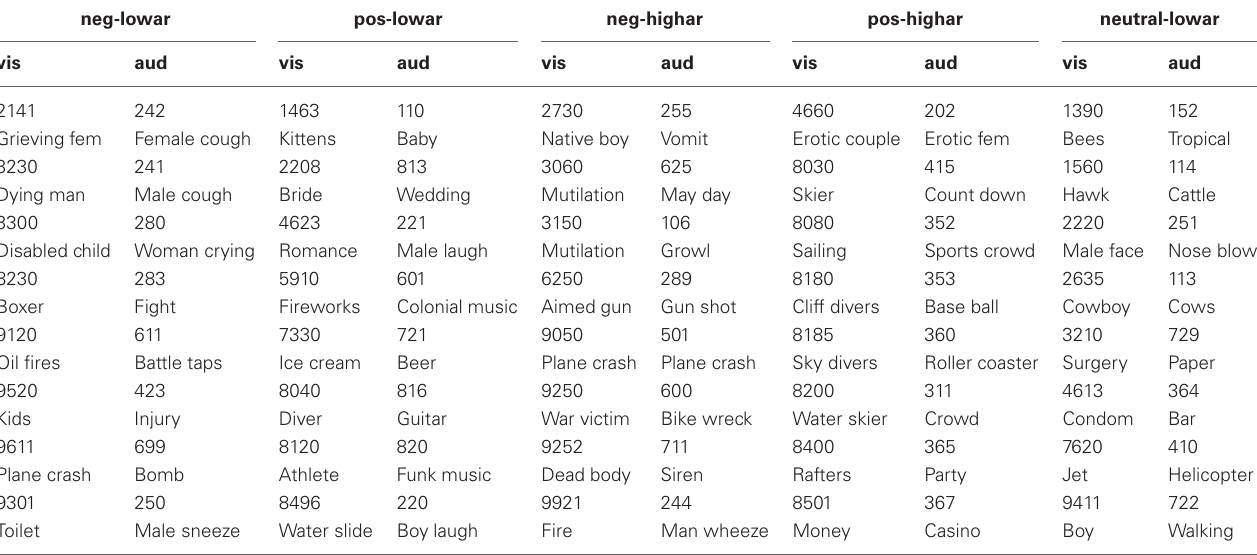
Table 1 | Numbers and names of the visual (IAPS) (Lang et al., 2005) and auditory (IADS) (Bradley and Lang, 2007) stimuli used in each of the five blocks (negative—low arousal, positive—high arousal, negative—high arousal, positive—high arousal, neutral—low arousal).